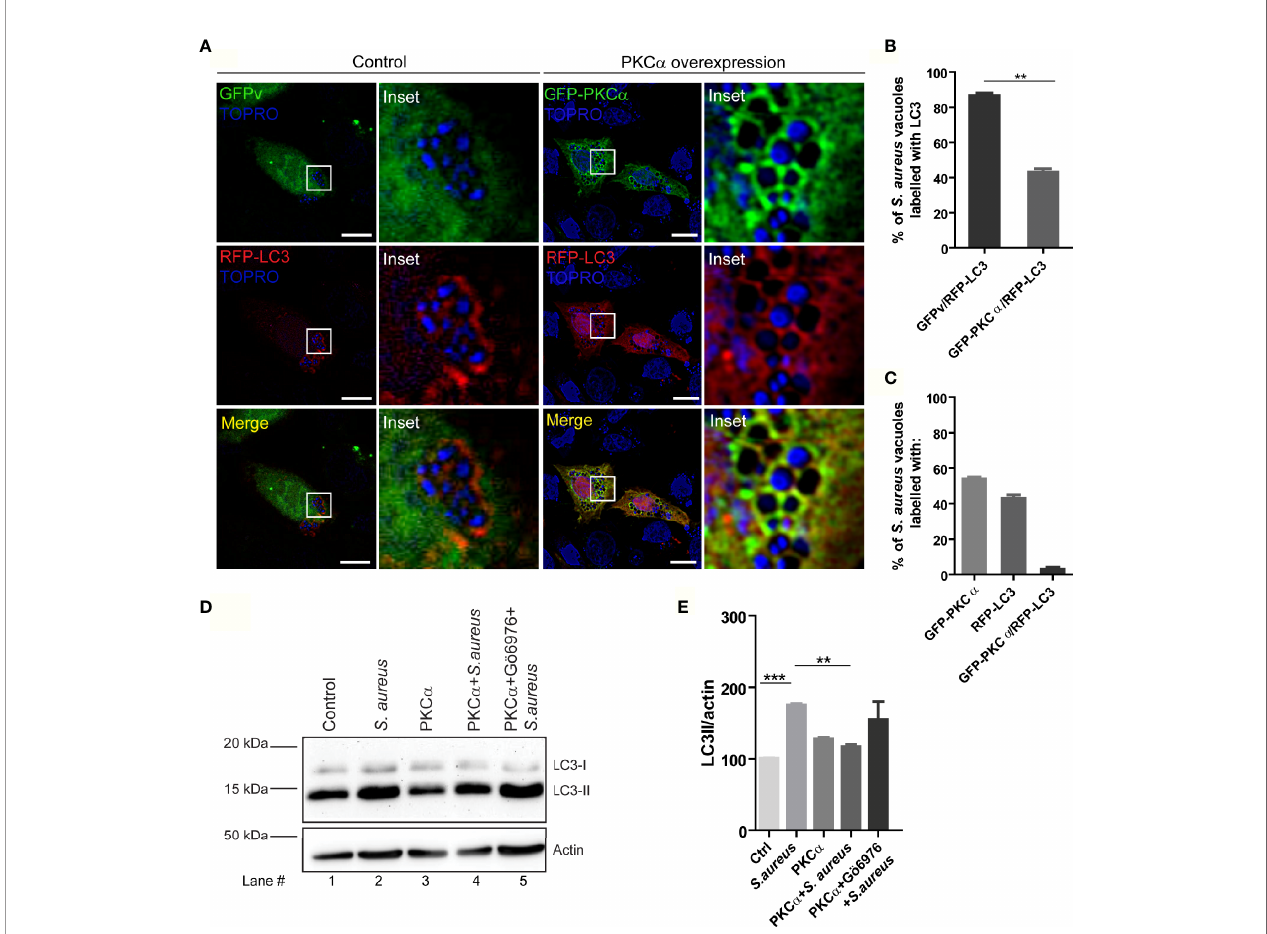
FIGURE 6 | PKC a inhibits autophagy induced by S. aureus . (A) Confocal microscopy images of CHO cells co-overexpressing GFP-PKC a or GFP empty vector (GFPv) and RFP-LC3 and infected for 4 hours with S. aureus wt. Bacteria were labelled with Topro, shown in blue. Bar: 10µm. Images are representative of fi ve independent experiments. (B) Quanti fi cation of S. aureus vacuoles recruiting RFP-LC3. **p ≤ 0.001. (C) Quanti fi cation of S. aureus vacuoles recruiting GFP-PKC a , RFP-LC3 or both. Data are the mean ± SEM of fi ve independent experiments. (D) Image of a Western blot analysis corresponding to a membrane incubated with speci fi c antibodies against LC3 and actin (as a loading control), of cell lysates obtained from CHO cells subjected to the following conditions: lane 1, control; lane 2, infected with S. aureus wt for 4 hours; lane 3, transfected with mCherry-PKC a ; lane 4, transfected with mCherry-PKC a and infected with S. aureus wt for 4 hours; line 5, transfected with mCherry-PKC a , treated with the PKC inhibitor Gö6976 (250 nM) and infected with S. aureus wt for 4 hours. The fi gure is representative of four independent experiments. (E) Quanti fi cation of the Western blot bands intensities with ImageJ. Data are the mean ± SEM of four independent experiments **p ≤ 0.001, ***p ≤